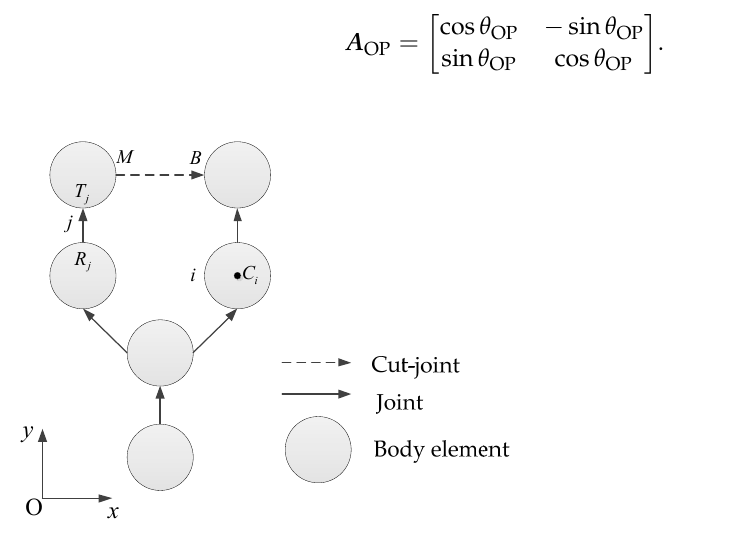
Figure 2. Sketch of the kinematic quantities.